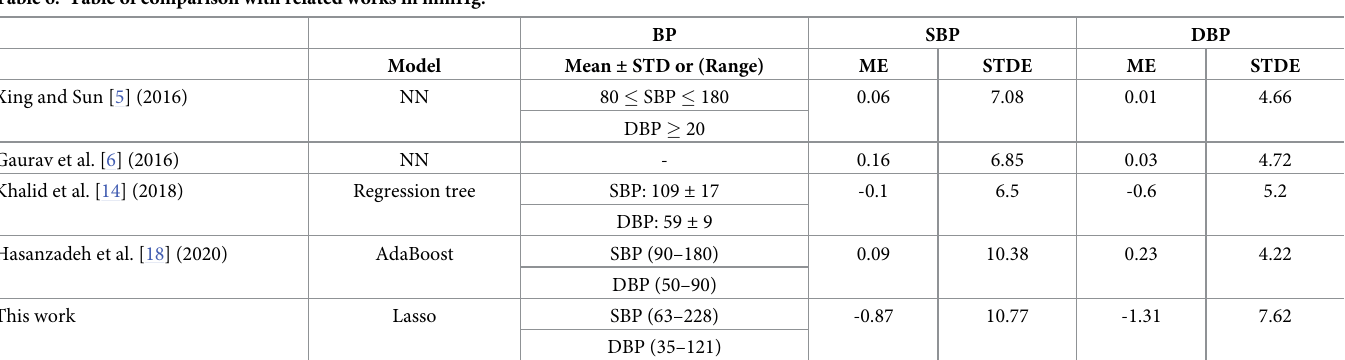
Table 6. Table of comparison with related works in mmHg.